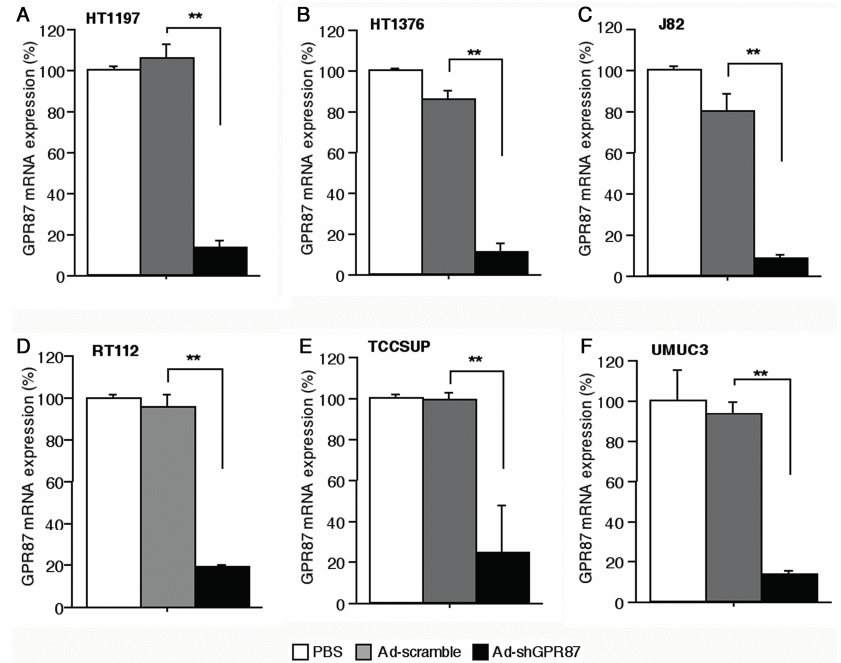
Figure 3. Ad-shGPR87 effectively knocked down GPR87 gene expression in six GPR87-overexpressing human bladder cancer cell lines (HT1197 ( A ); HT1376 ( B ); J82 ( C ); RT112 ( D ); TCCSUP ( E ) and UMUC3 ( F ) cells). Gene expression of GPR87 was assesed with real-time PCR 3 days after infection with Ad-shGPR87 at a MOI of 20. MOI: multiplicity of infection; ** p < 0.005, vs. Ad-scramble